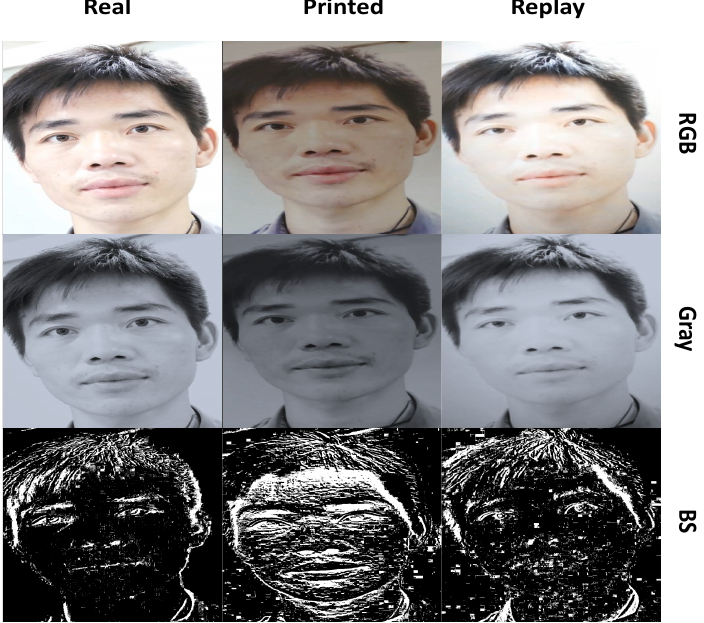
Figure 2. Example of a genuine face and corresponding print and replay attacks in grey-scale and